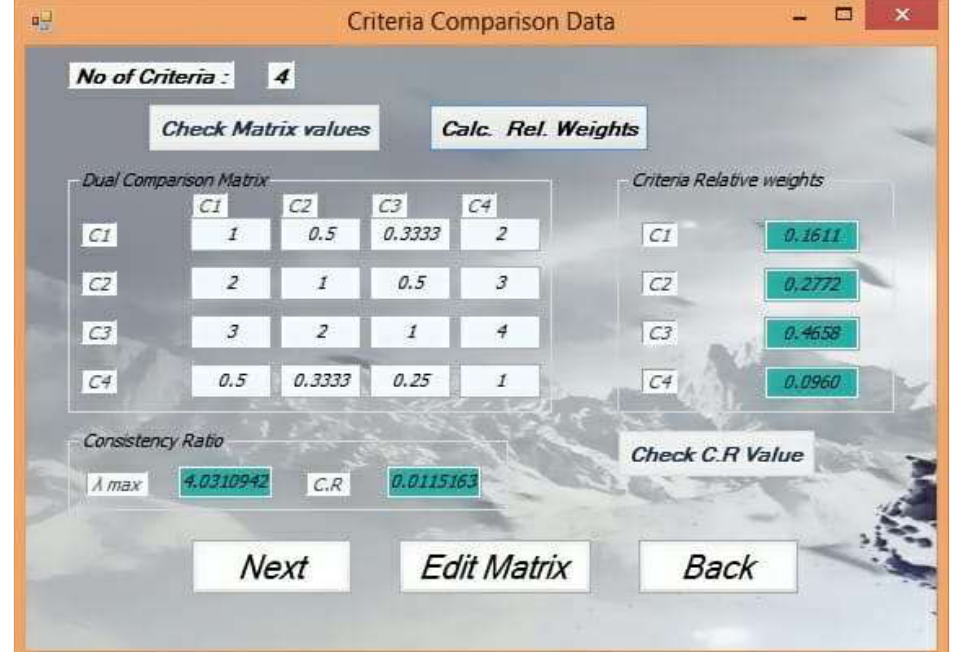
Figure 5. Location of the investigated project.